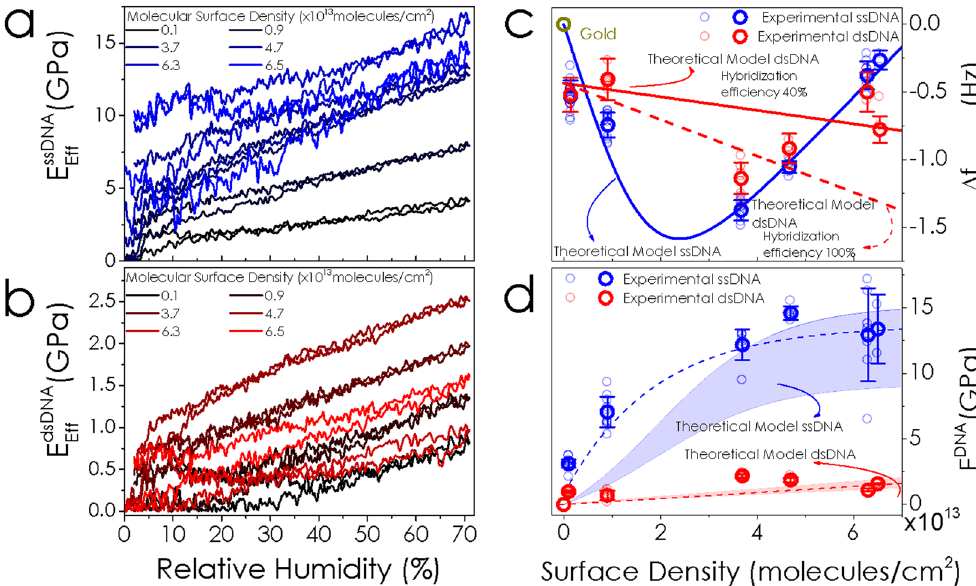
Figure 3. Modulation of the effective Young’s modulus of the DNA layer. Experimental tracking of the ssDNA ( a ) and dsDNA ( b ) Young’s modulus during a hydration and dehydration cycle for a cantilever immobilized with increasing surface density of DNA molecules. By increasing the environmental relative humidity, the effective Young’s modulus linearly increases, showing no-hysteresis features. The effective Young’s modulus for the dsDNA is not only one order of magnitude lower but also less sensitive to external humidity variation due to the double helix shielding effect. ( c ) Theoretical model (lines) and experimental measurement (symbols) of frequency shifts for fully hydrated DNA. The frequency shift for ssDNA (blue circles) decreases for low surface coverage until a critical value, where it increases again. The experimental shifts in frequency for varying dsDNA coverage are represented in red circles. The discrepancy with the theoretically calculated shift (red dashed line) could be attributed to the experimentally inhomogeneous hybridization surface coverage. The red solid line considers that the hybridization efficiency is of about 40% whereas there is a nonspecific adsorption of about 15% of DNA strands. ( d ) Young’s modulus for fully hydrated ssDNA (blue symbols) and dsDNA (red symbols) as a function of molecular surface density. The theoretical calculations (bluish and reddish areas respectively for ssDNA and dsDNA) match the experimental values (open symbols). While the Young’s modulus for the ssDNA reaches an asymptotic value of ~15 GPa, the value for the dsDNA only reaches a maximum value of ~2 GPa due the double helix